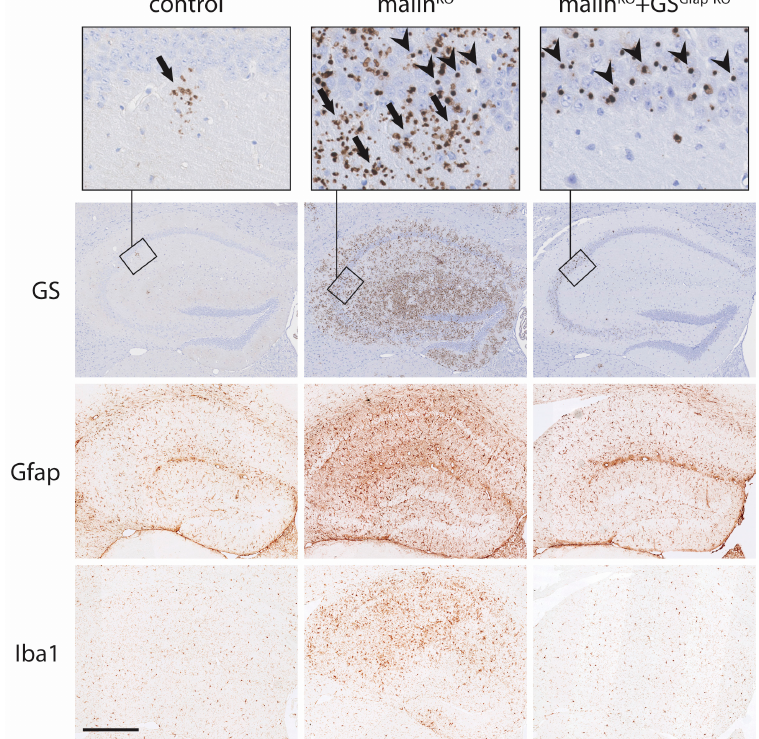
Figure 2. Accumulation of glycogen aggregates in neurons and astrocytes and neuroinflammation in mouse models of LD. GS, glial fibrillary acidic protein (Gfap) and ionized calcium-binding adapter molecule 1 (Iba1) immunostainings of mouse hippocampi are shown. GS immunostaining